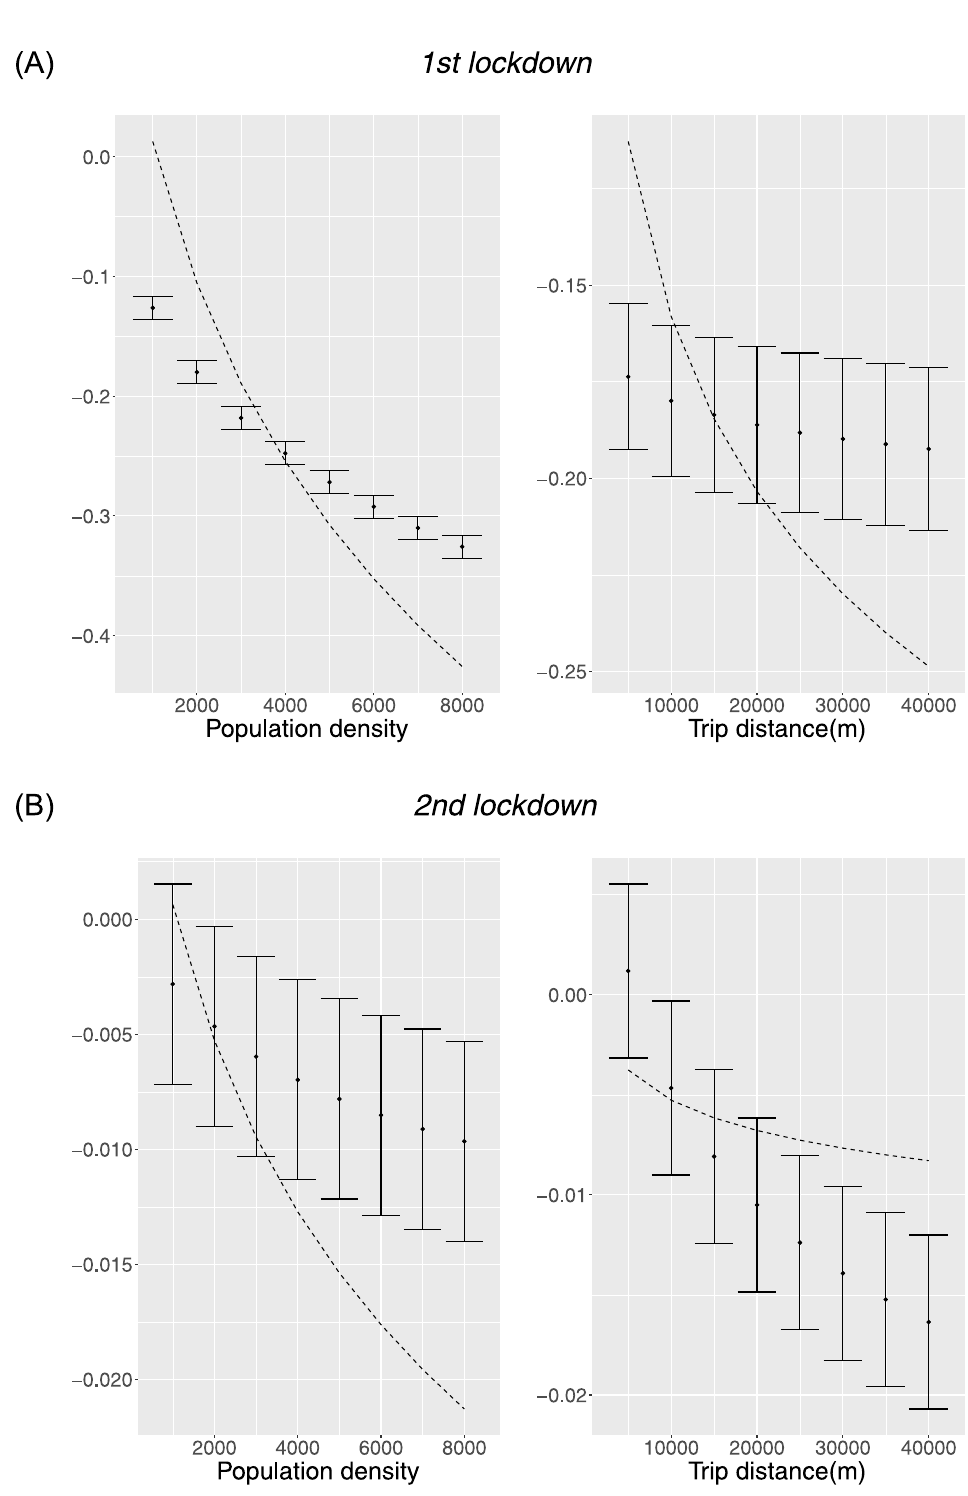
Fig 8. Total marginal effects of the lockdowns: (A)First lockdown; (B) Second lockdown. The total marginal effects of each lockdown are described by β 0 single and cross terms of the mth lockdown in Model 2 of Table 1. The dashed lines show the total effects of the IFC under the same conditions. Those with the first lockdown are multiplied by 20 in the left, Population density, and 30 in the right, Trip distance (m). However, no scale adjustment is performed for the second